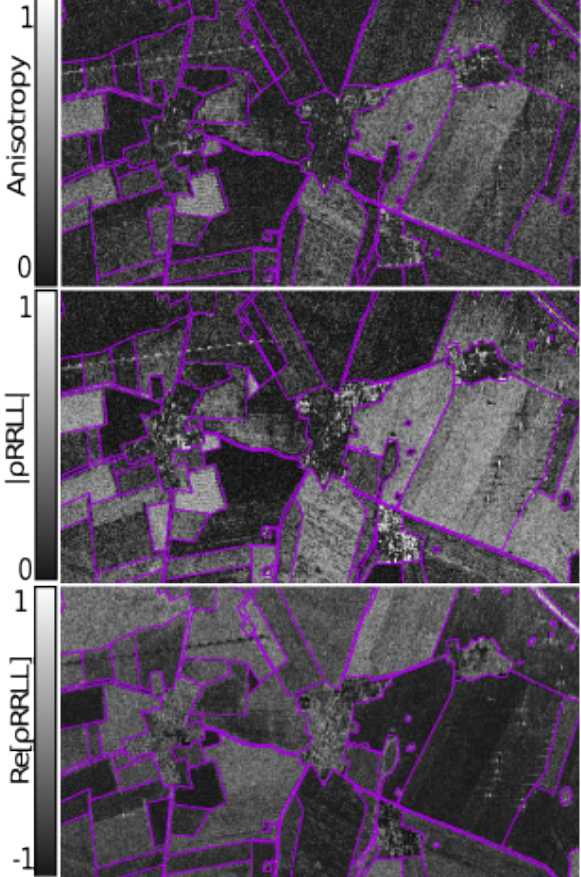
Figure 4. Examples of calculated roughness estimators from fully polarimetric L-Band data acquired at the 19th of April